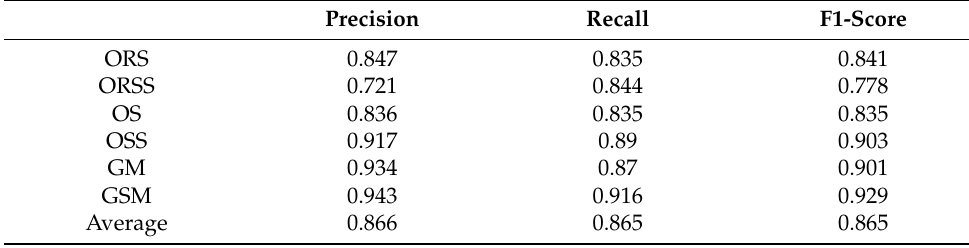
Table 4. Precision, recall, and F1-score of Random forest model on a test